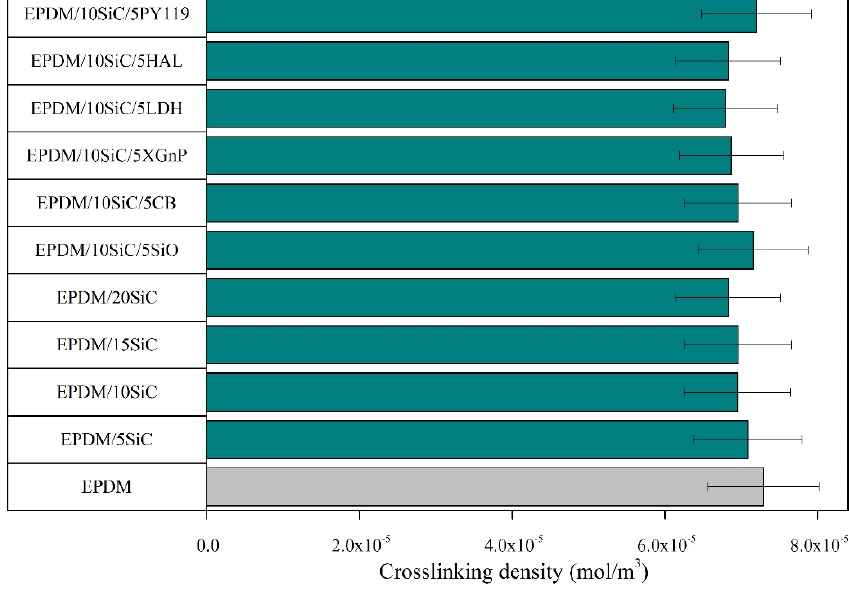
Figure 2. Cross-link density of EPDM vulcanizates filled with SiC or SiC hybrid systems.